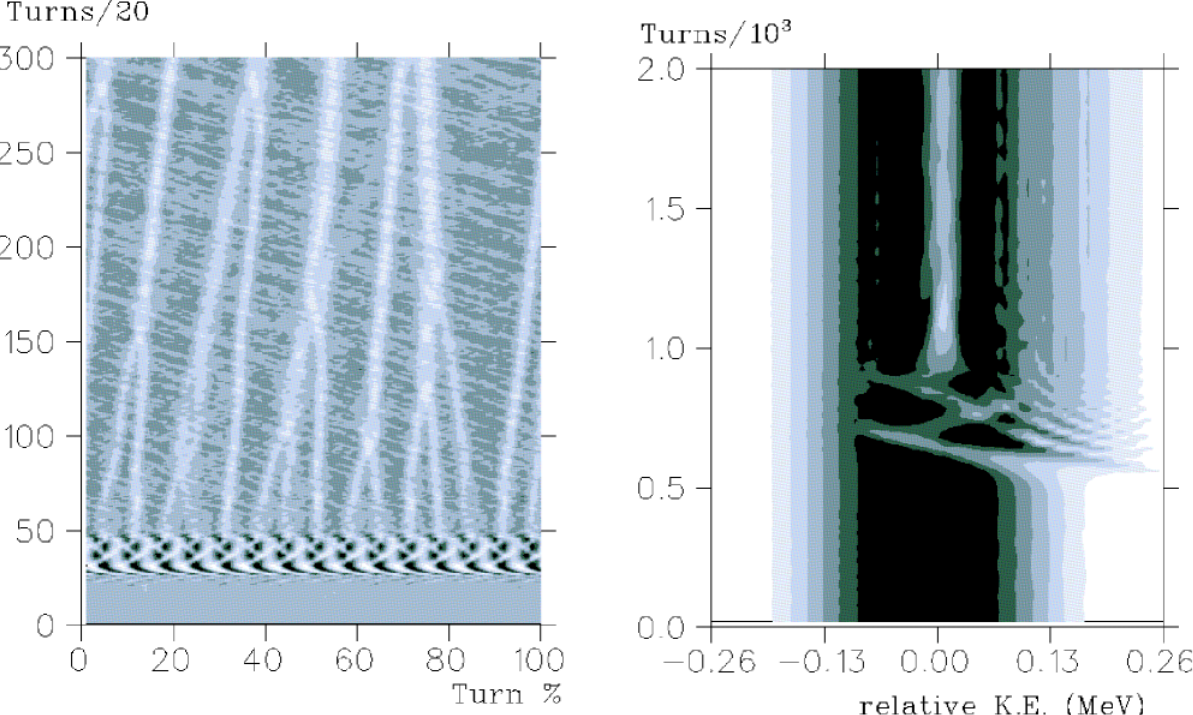
FIG. 18. Waterfall plots of line density (left) and energy spectrum (right) for 6000 and 2000 turns, respectively. 2 3 10 12 protons, 8 3 10 5 macroparticles.